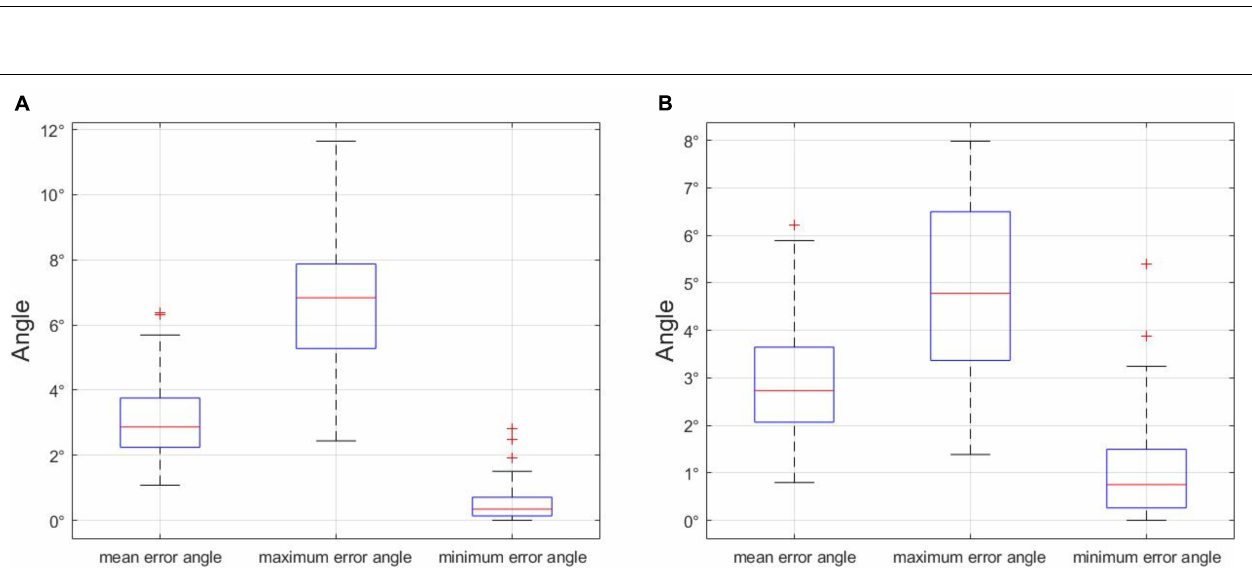
FIGURE 14 | (A) Error angle analysis of the whole stem node of soybean plant, and (B) error angle analysis of stem node of the lower half of soybean plant. Statistical analysis of error angles.